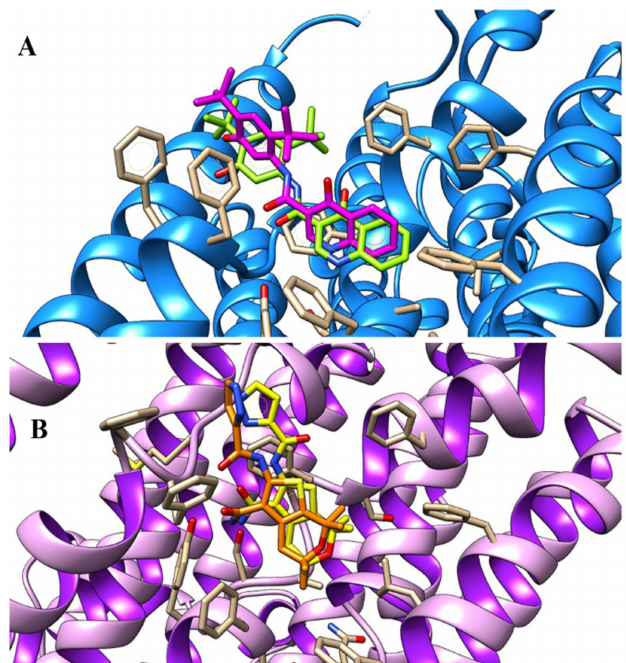
Figure 2. Docking positioning of VX-770 ( C atom; magenta) ( A ) and of GLPG1837 ( C atom; orange) ( B ) within the X-ray crystallographic data 6O2P and 6O1V, respectively. The co-crystallized ligands are shown in green and yellow